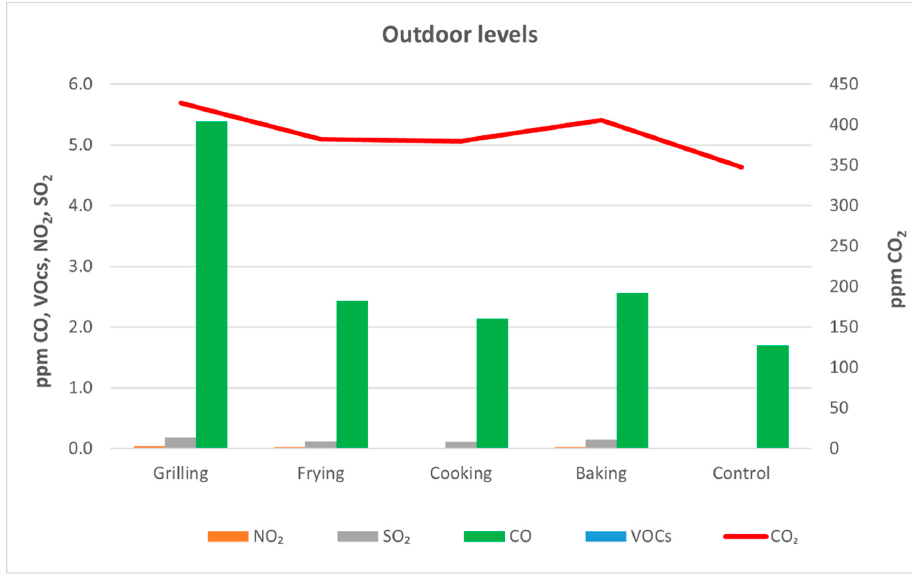
Figure 3. Mean levels of air pollutants in the surrounding areas outdoor of restaurants.